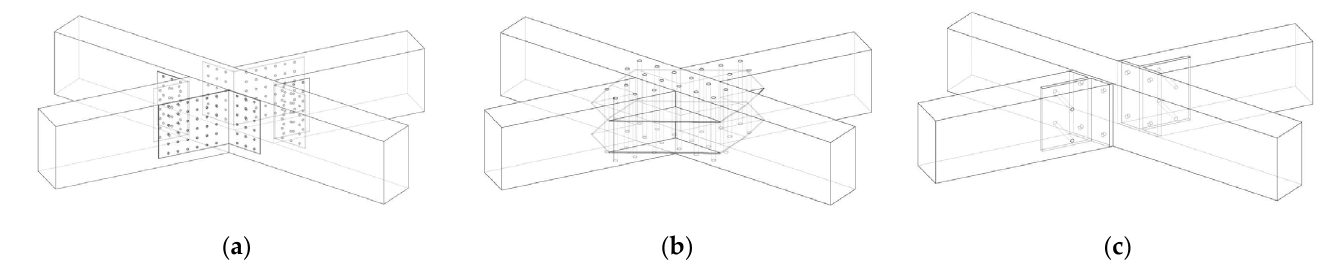
Figure 9. ( a ) Timber lamellae joint with bent steel plates nailed to the lamellae. ( b ) Timber lamellae joint with horizontal steel plates let into slits and nailed. ( c ) Timber lamellae joint with T-section steel plates dowelled to lamellae.